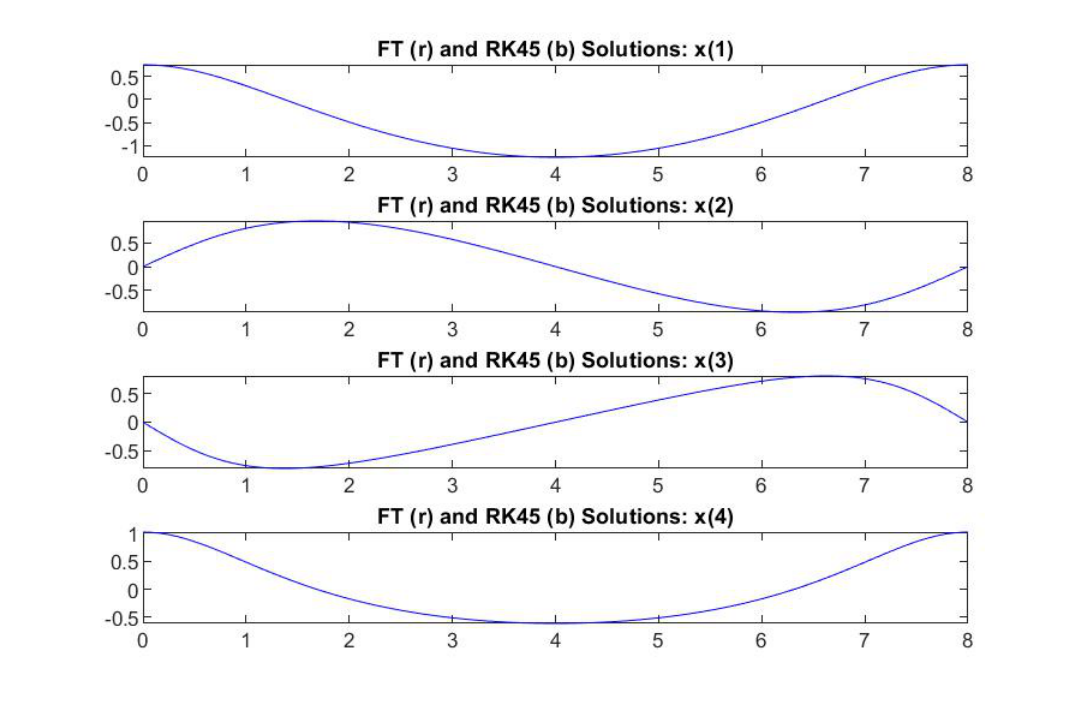
Figure 8. Problem No5 (Periodic system): The four components x j ( t ) , j = 1,2,3,4 are displayed in the order from top to bottom; FT solution is red-colored, RK solution is blue-colored and the two coincide at graphical